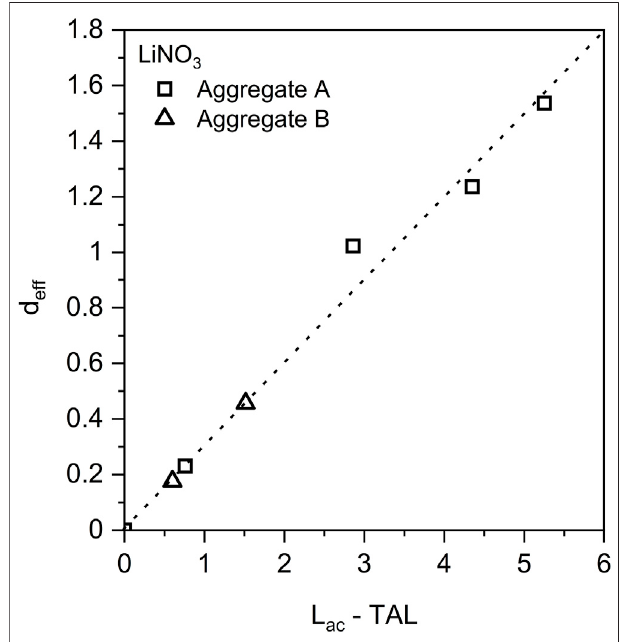
FIGURE 4 | Relationship between the effective dosage of lithium nitrate (d eff ), the alkali content of concrete (L ac ), and the threshold alkali level (TAL) of the aggregates. Data reproduced from (Berra et al.,